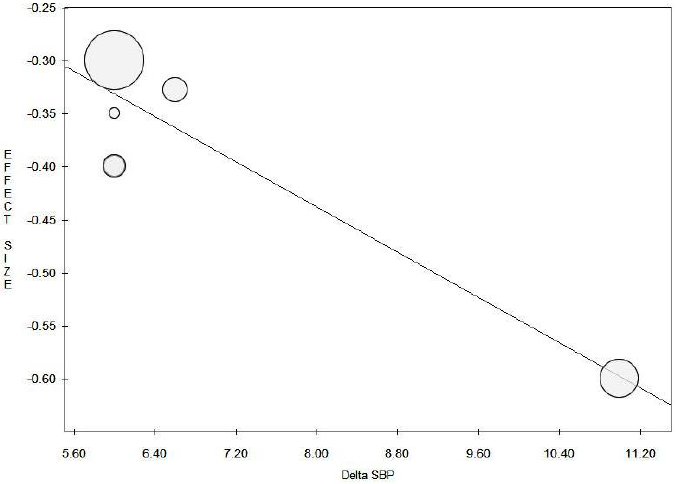
Figure 4. Meta regression of differences in systolic blood pressure and overall unstandardized mean difference of six studies evaluating proteinuria. Y = −0.01 + (−0.05); p = 0.005.